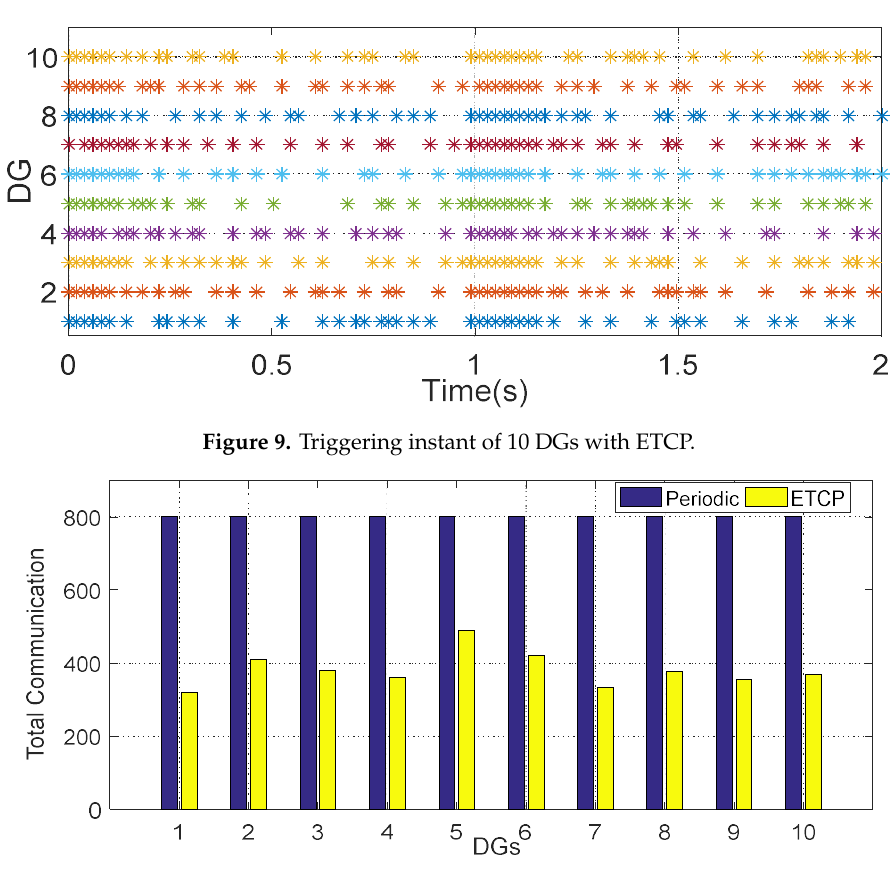
Figure 8. Control input with ETCP